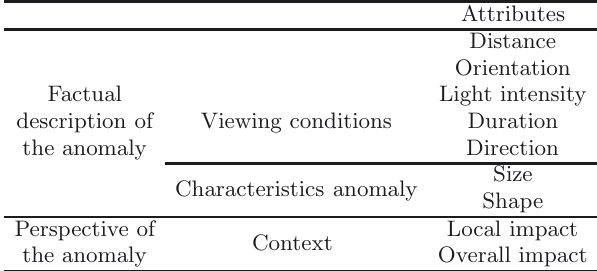
Table 2. Aesthetic anomaly